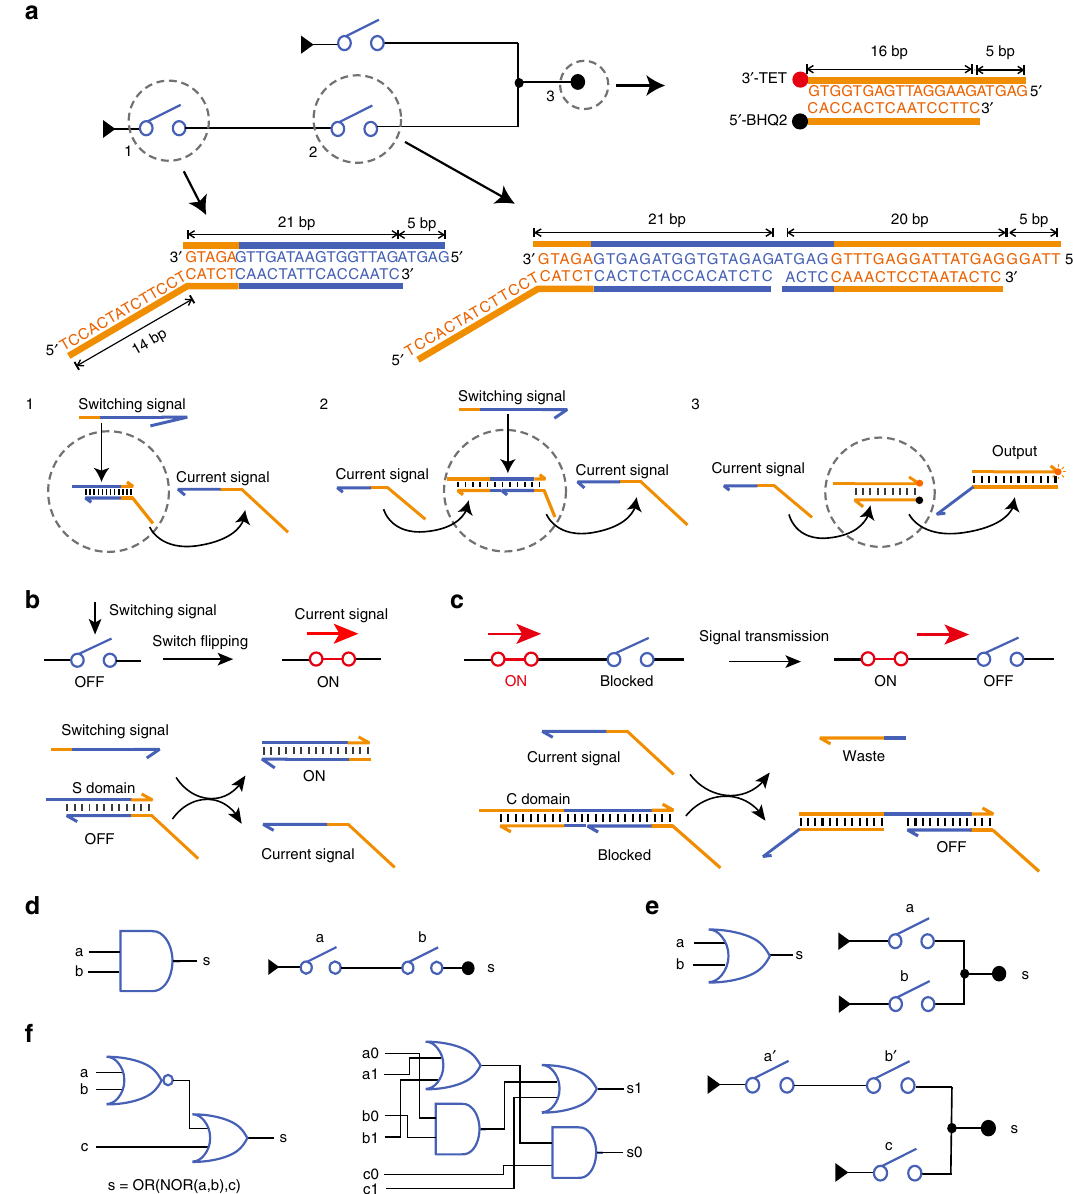
Fig. 1 DSC-based implementation of Boolean computation. a Schematic illustration and molecular details of the DSC system. Typically, a DSC contains three types of elementary molecules: (1) Starting switch that responds to its switching signal. (2) Downstream switch that responds to current signal and switching signal. (3) Reporter that responds to current signal and generates fl uorescent output. b Schematic illustration and DNA implementation for switching signal response. c Schematic illustration and DNA implementation for current signal transmission. d AND logic and the corresponding SC. e OR logic and the corresponding SC. f Left: a NOR-OR circuit with NOT operation. Middle: dual-rail representation of the NOR-OR circuit. Right: SC implementation, where a ’ and b ’ represent the complementary value of a and b,